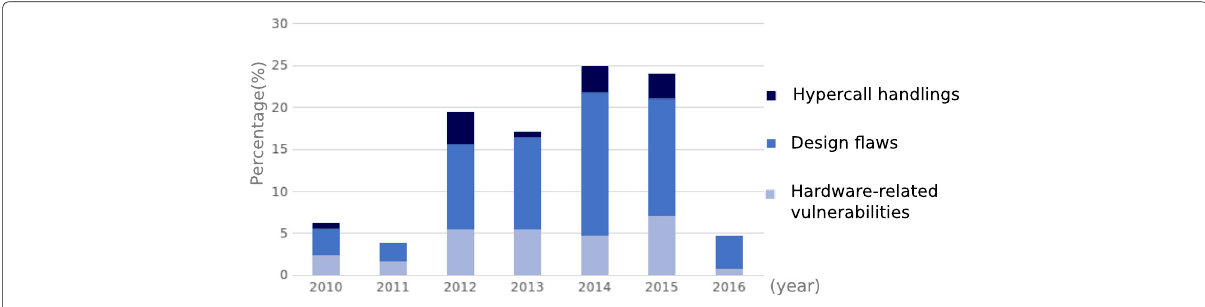
Fig. 3 Vulnerabilities exploited for hypervisor